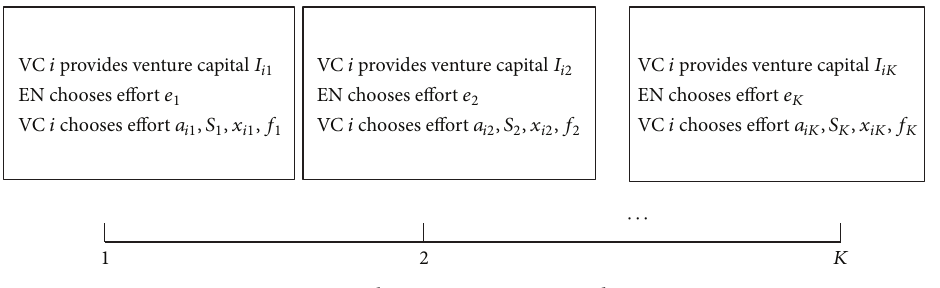
Figure 1: Multistage joint investment